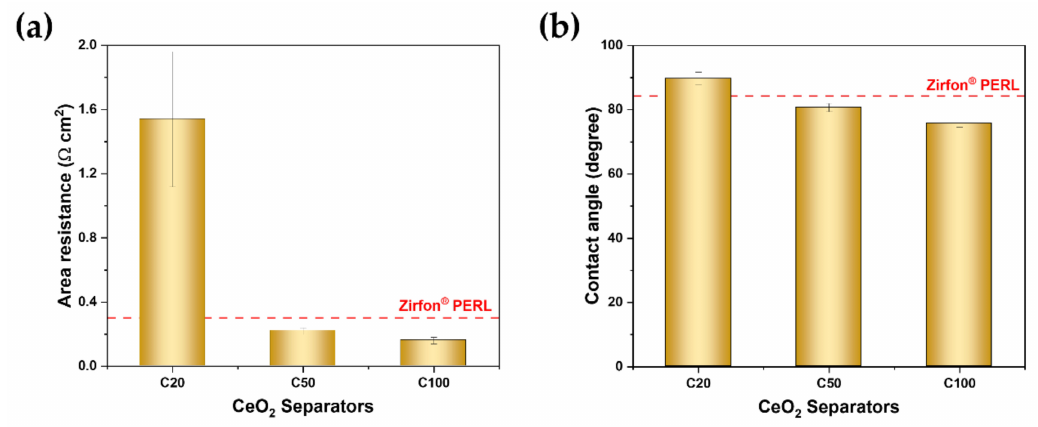
Figure 3. ( a ) Area resistance and ( b ) wettability of the composite separators and